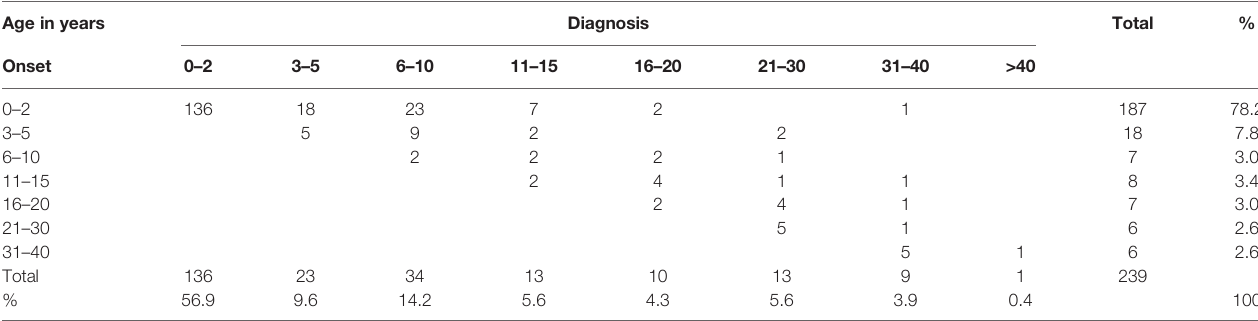
TABLE 2 | Distribution of patients with IEI in the categories of age according to onset and diagnosis. Age in years